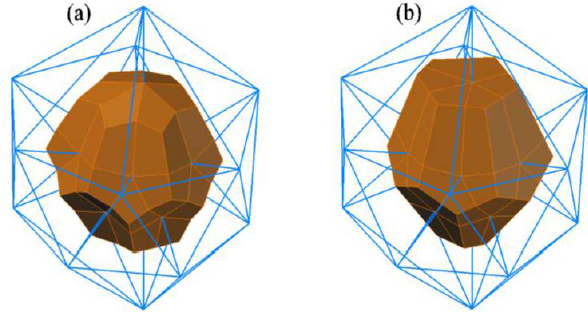
Figure 34: The barycentric dual mesh (a) and the dual mesh of Voronoi (b) three-dimensional domains.